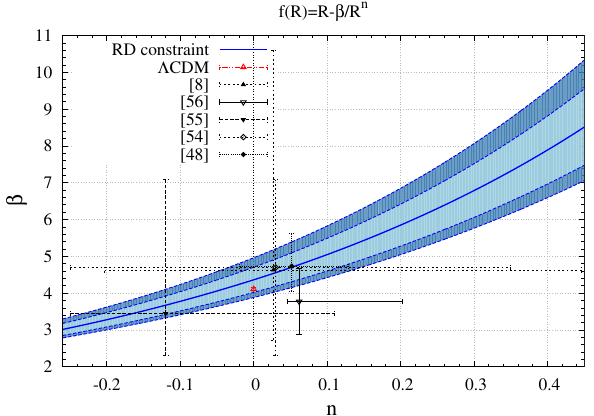
Fig. 2 Constraintontheparameterspace (α,β) fortheoriesofthetype f ( R ) = R + α ln R − β comingfromthecosmographicapproachtothe redshift drift, together with the best-fit values previously reported and the Λ CDM case. The shadowed region indicates the error propagation associated to the Ω m , 0 and q 0 values, and a forecast corresponding to a measurement of q 0 with an error of 10% of its value BAO and CMB observations were obtained in [8], with best- + 1 . 75 , 4 . 62 + 3 . 54 ) . A more fit values (α, β) = ( 0 . 11 − 1 . 11 − 5 . 58